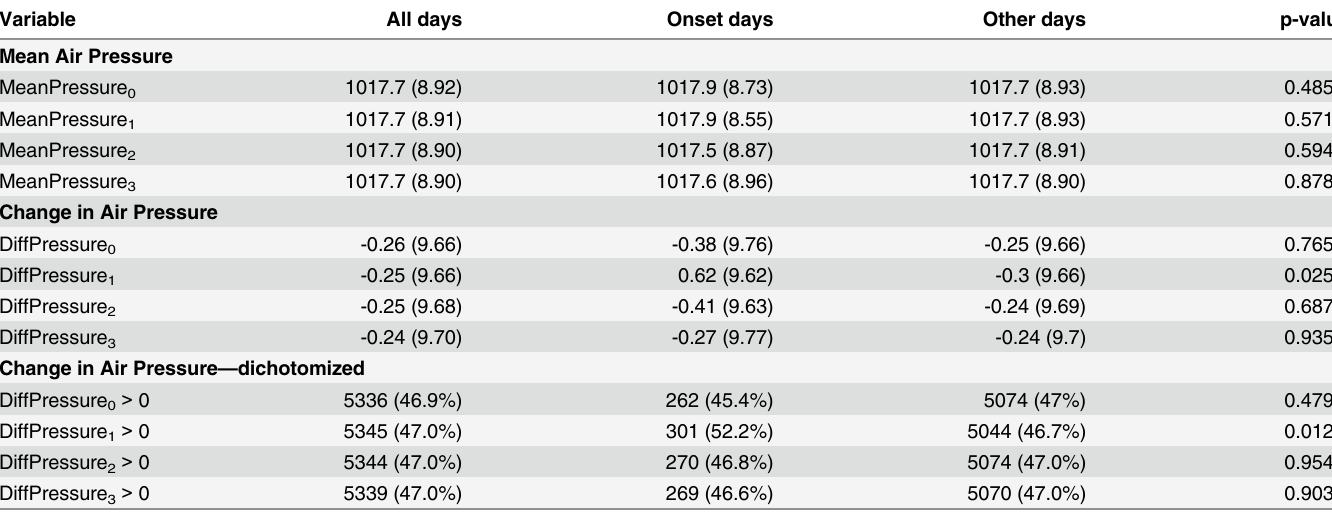
Table 3. Atmospheric pressure parameters before onset of MD episodes.